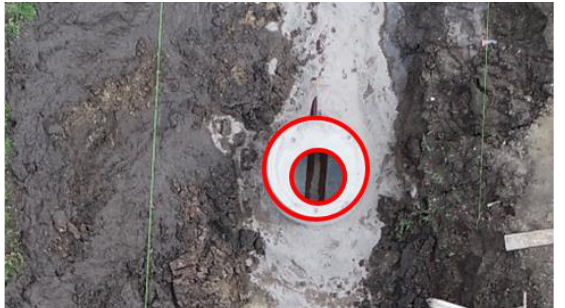
Figure 9. The border of the sub-foundation isn't detectable on the mesh, the sub-foundation isn't finished yet.